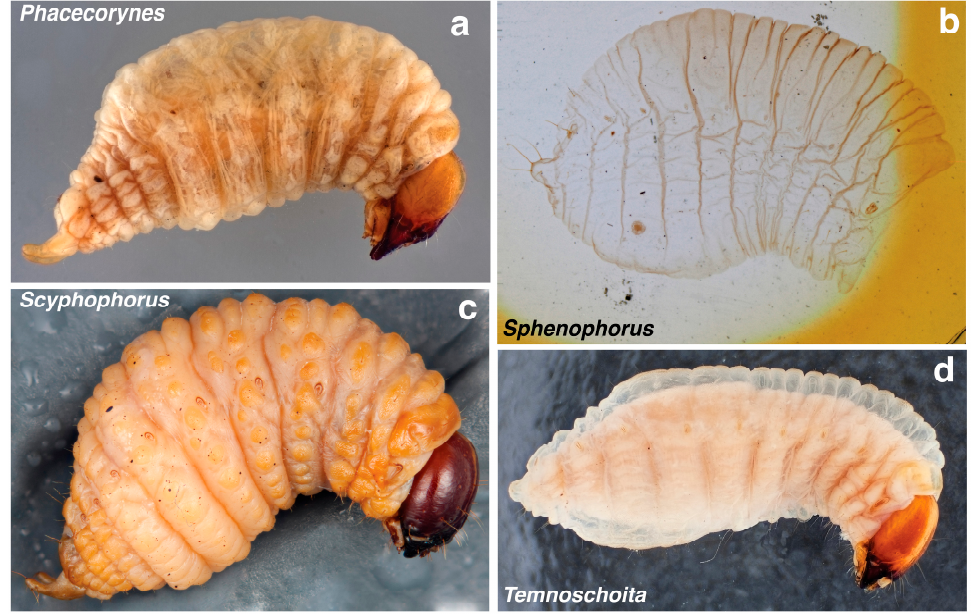
Figure 2. Larva, lateral view: ( a ) Phacecorynes ; ( b ) Sphenophorus ; ( c ) Scyphophorus ; and ( d ) Temnoschoita .